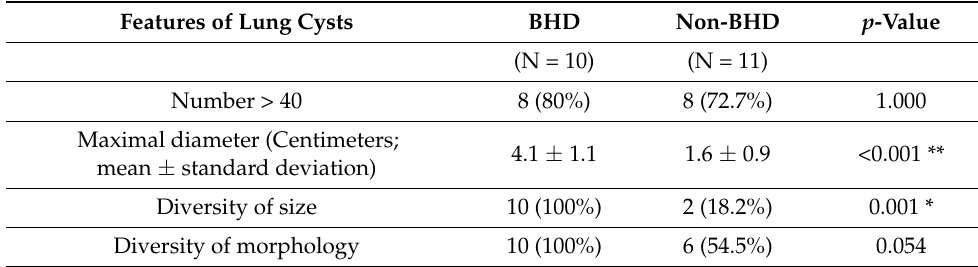
Figure 1. Differences in the characteristics of lung cysts between the BHD and non-BHD groups. ( A ): Transverse plane view of chest computed tomography for BHD patients. ( B ): Transverse plane view of chest computed tomography for non-BHD. ( C ): Gross pathology images of lung cysts in BHD patient, The number of cyst is same as marked number in chest computed tomography image ( A ). BHD: Birt–Hogg–Dube syndrome. Table 3. Characteristic chest CT findings according to FLCN gene mutation status.